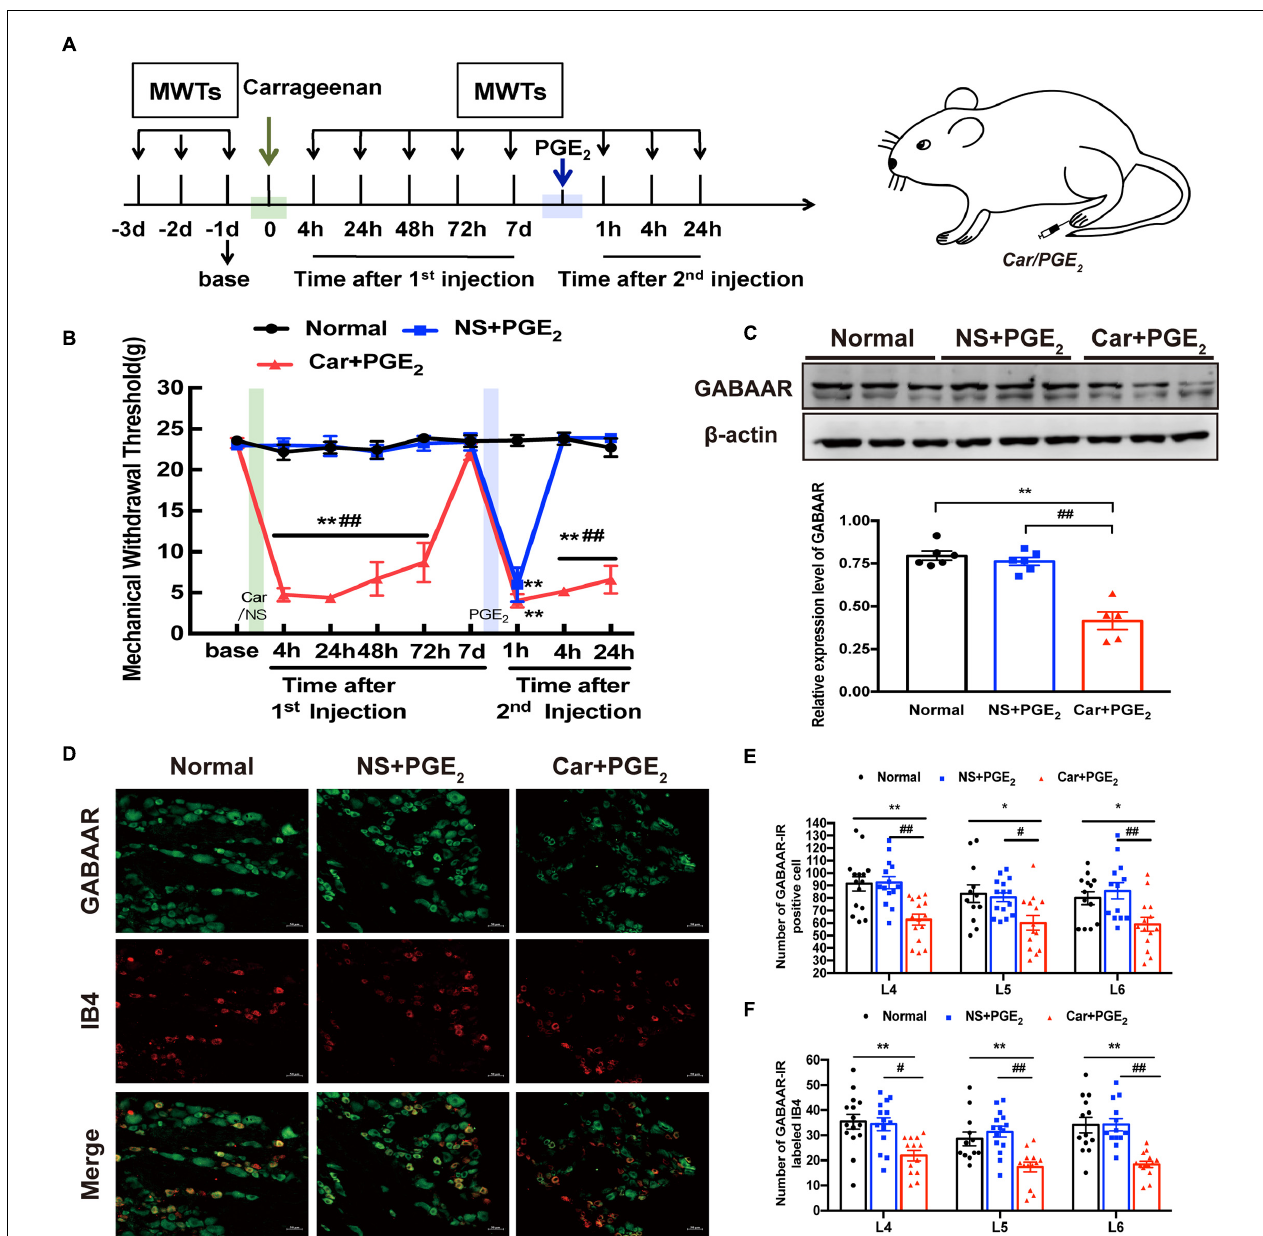
FIGURE 1 | GABAAR in the L4-L6 DRGs plays a key role in the hyperalgesic priming model (A) Schedule of the experimental protocol. The hyperalgesic priming model was established by sequential intraplantar injection of carrageenan (Green arrow, 1 mg/100 µ L/paw) and PGE 2 (Blue arrow, 100 ng/25 µ L/paw) into the left hind paw. (B) The mechanical withdrawal threshold (MWT) of rats that received carrageenan (Green line) and PGE 2 (Blue line) injections. (C) The quantification of the Western blots results and a representative Western blot showing GABAAR protein isolated from the DRG 24 h after 2nd injection. (D) Representative images of GABAAR-IR positive neurons (green) merged with IB4 neurons (red) in lumbar DRG of hyperalgesic priming rats. (E) The quantification of GABAAR-IR positive neurons in L4, L5, and L6 DRG, respectively. (F) The quantification of GABAAR-IR positive neurons labeled with IB4 in L4, L5, and L6 DRG, respectively. 15 sections from three different rats. Data are presented as mean ± SEM, n = 6; * P < 0.05, ** P < 0.01 vs. Normal group, # P < 0.05, ## P < 0.01 vs. NS + PGE 2 group. P < 0.01 indicate significant differences according to ANOVA followed by Bonferroni post hoc analysis.